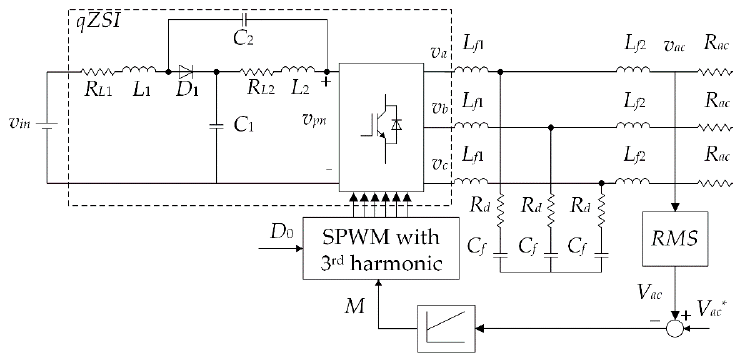
Figure 1. Control system of the qZSI in a stand-alone operation mode.